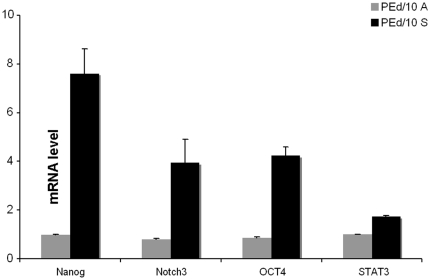
Real -time RT-PCR data.Stem cell markers in adesion and sphere cells. The data are presented as mean +/−SD of three independent experiments showing p<0.05 statistical analysis.